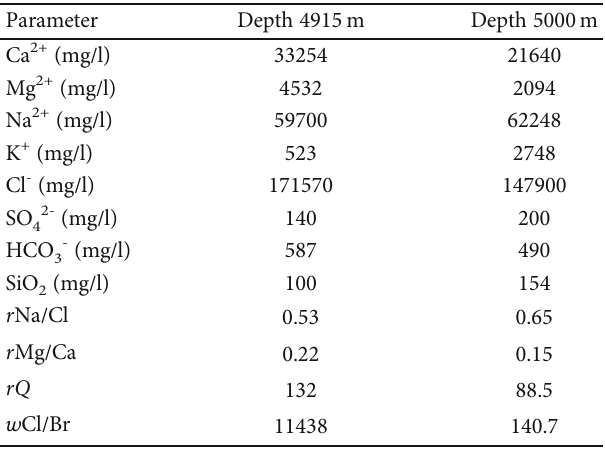
Table 2: Chemical composition of Triassic brines in borehole MJ1. Cl - /Br - are in weight ratio; all other ratios are based on